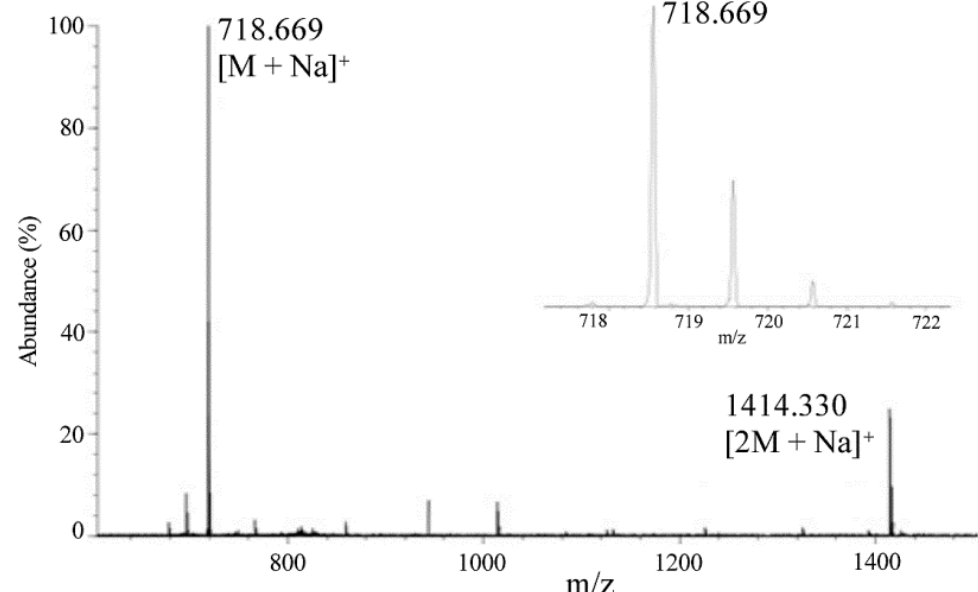
Figure 4. Sheath flow ESI mass spectrum of reaction A, mixture. [M + Na] + is observed for the product. Note the improved resolving power compared to data in Figure 2.